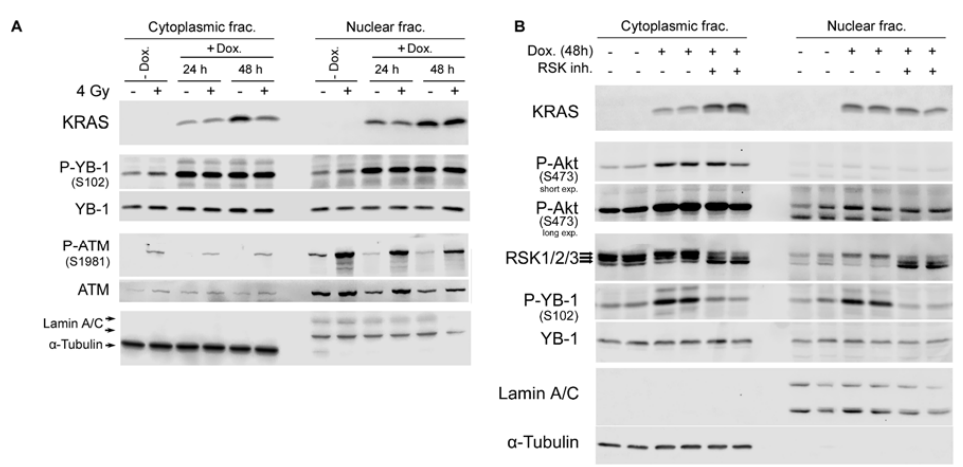
Figure 4. Conditional expression of KRAS(G12V) in the colorectal carcinoma cell line Caco2 induces YB-1 phosphorylation in the nucleus by stimulating RSK nuclear translocation. ( A ) Cells were treated with doxycycline (2 µg/mL) for the indicated times and mock irradiated or irradiated (4 Gy). Cytoplasmic and nuclear fractions were prepared 30 min after irradiation. ( B ) KRAS(G12V) was conditionally induced after treatment with doxycycline for 48 h. Treatment with the RSK inhibitor LJI308 (5 µM, 24 h) was performed followed by cytoplasmic and nuclear protein preparation. KRAS, P-YB-1, YB-1, P-ATM, ATM, and RSK1/2/3 levels were assessed via Western blotting. α -Tubulin and lamin A/C were detected as cytoplasmic and nuclear markers. Arrows indicate distinct RSK isoforms.